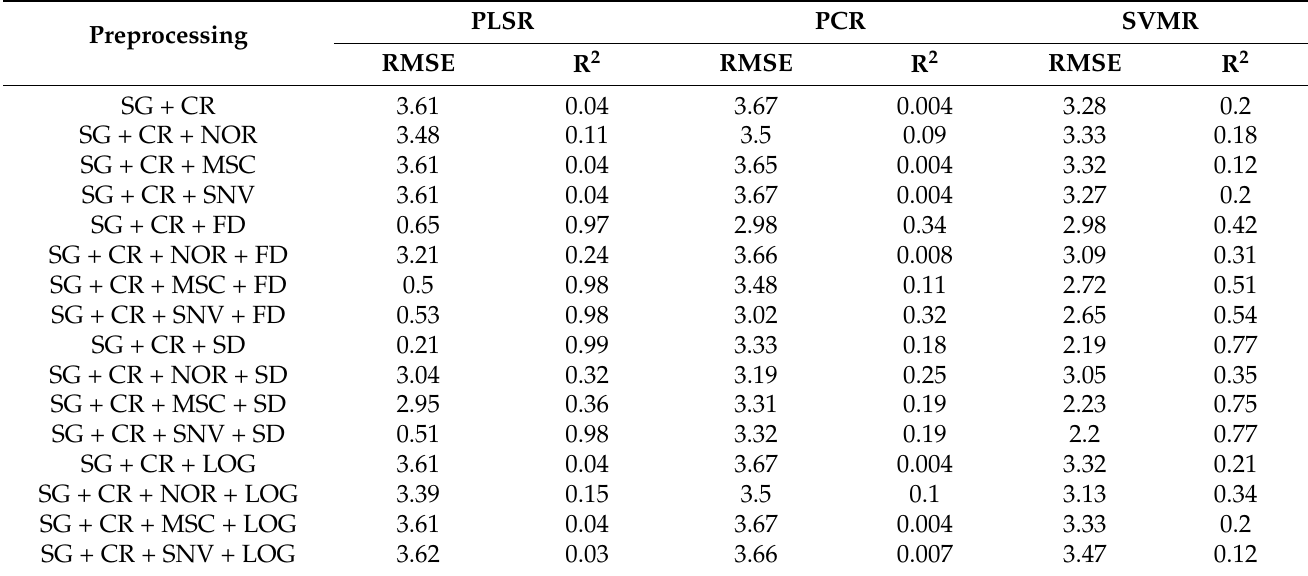
Table 5. Determination accuracies of Cr concentrations based on spectral bands associated with SOM.